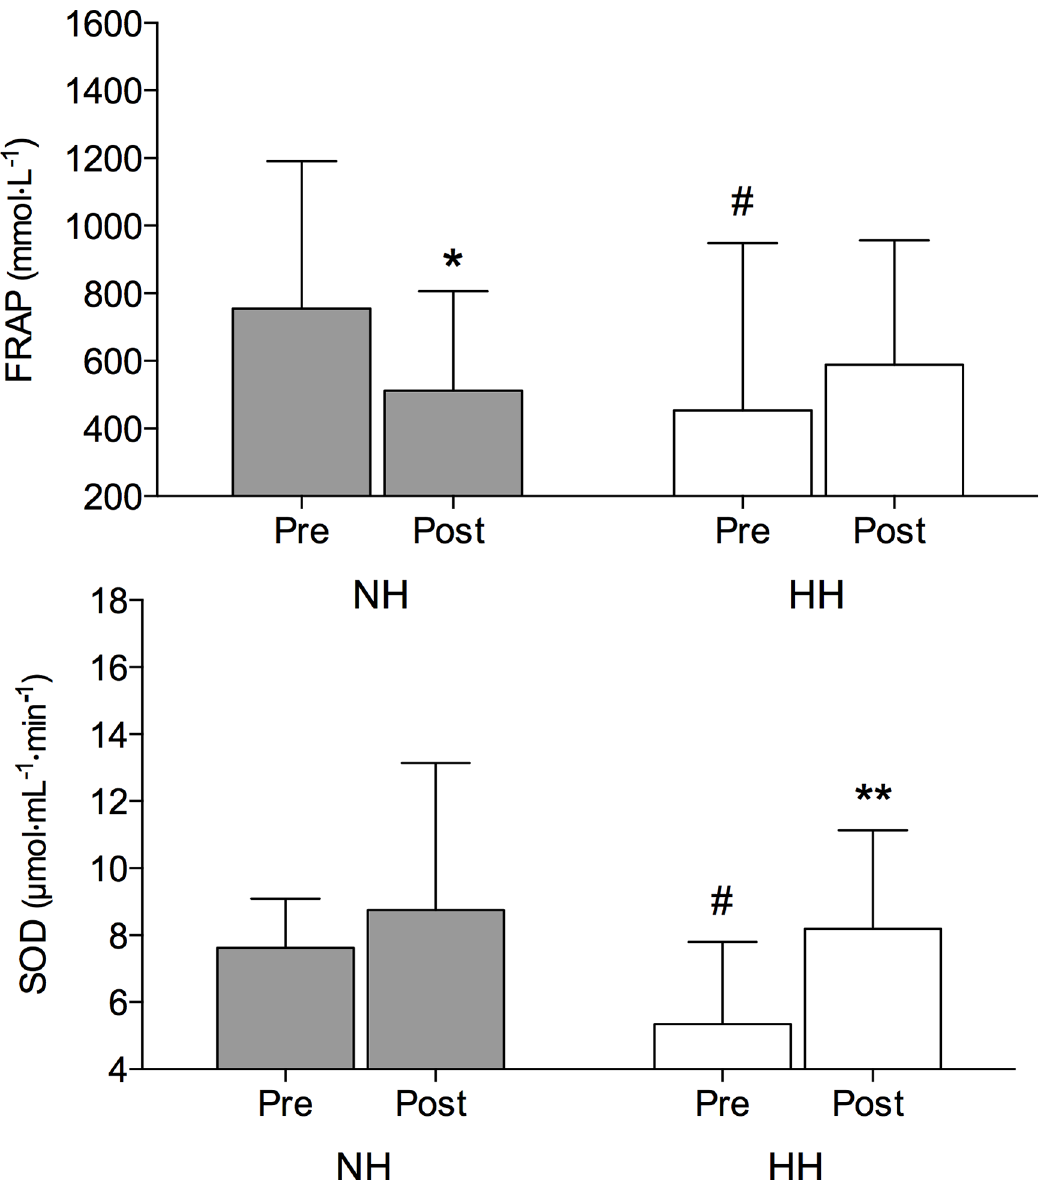
Fig 2. Ferric-reducing antioxidant power (FRAP; upper panel) and Superoxide dismutase (SOD; lower panel) plasma values (mean ± SD) before (Pre) and immediately following (Post) the normobaric (NH) and hypobaric (HH) LHTL protocol. Significant post hoc differences: * P < 0.05, ** P < 0.01 vs. Pre value; # P < 0.05 vs. corresponding NH LHTL